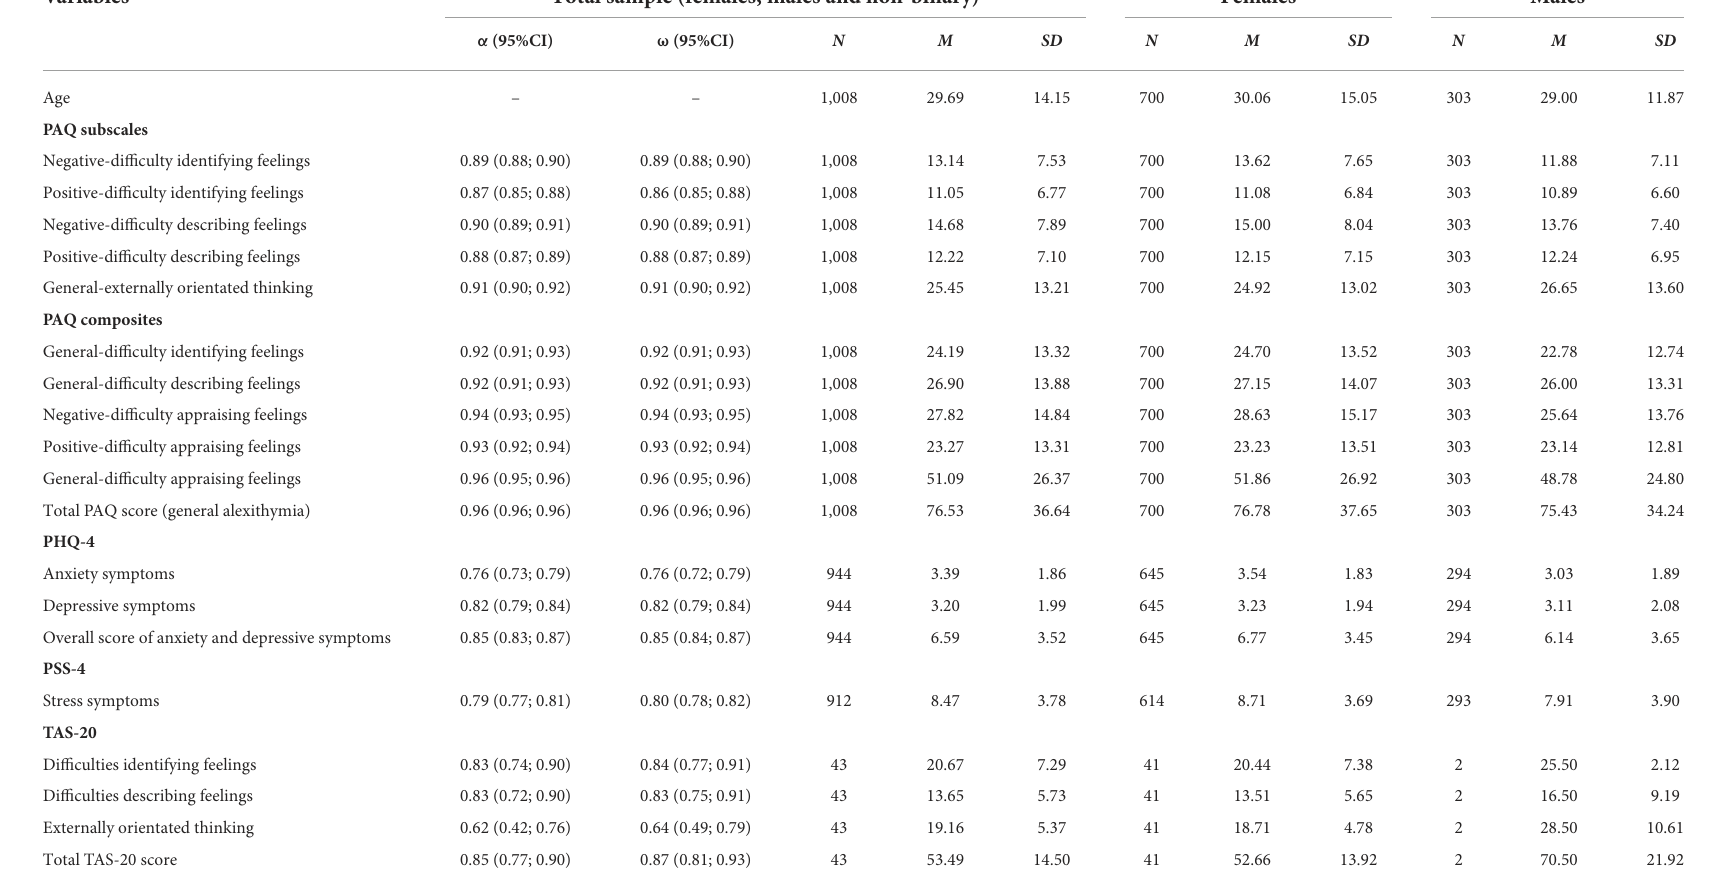
TABLE 2 Descriptive statistics and Cronbach’s alpha ( α ) and McDonald’s omega values ( ω ) with 95% confidence intervals (CI) for the PAQ, PHQ-4, PSS-4 and